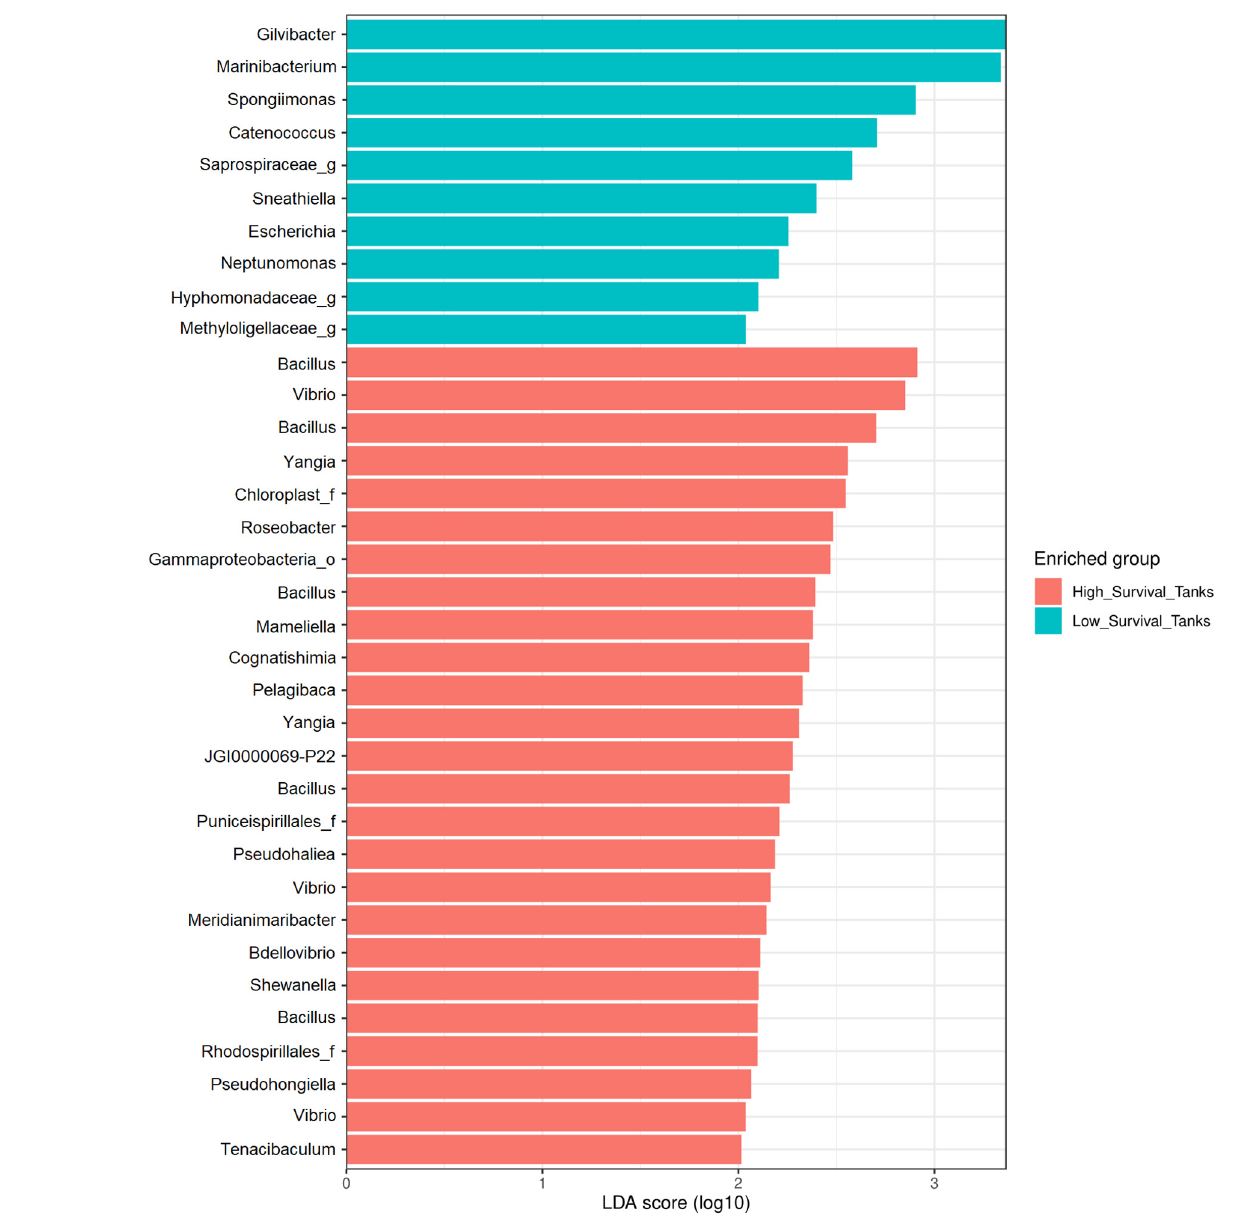
and domesticated adult P. monodon (Rungrassamee et al.,